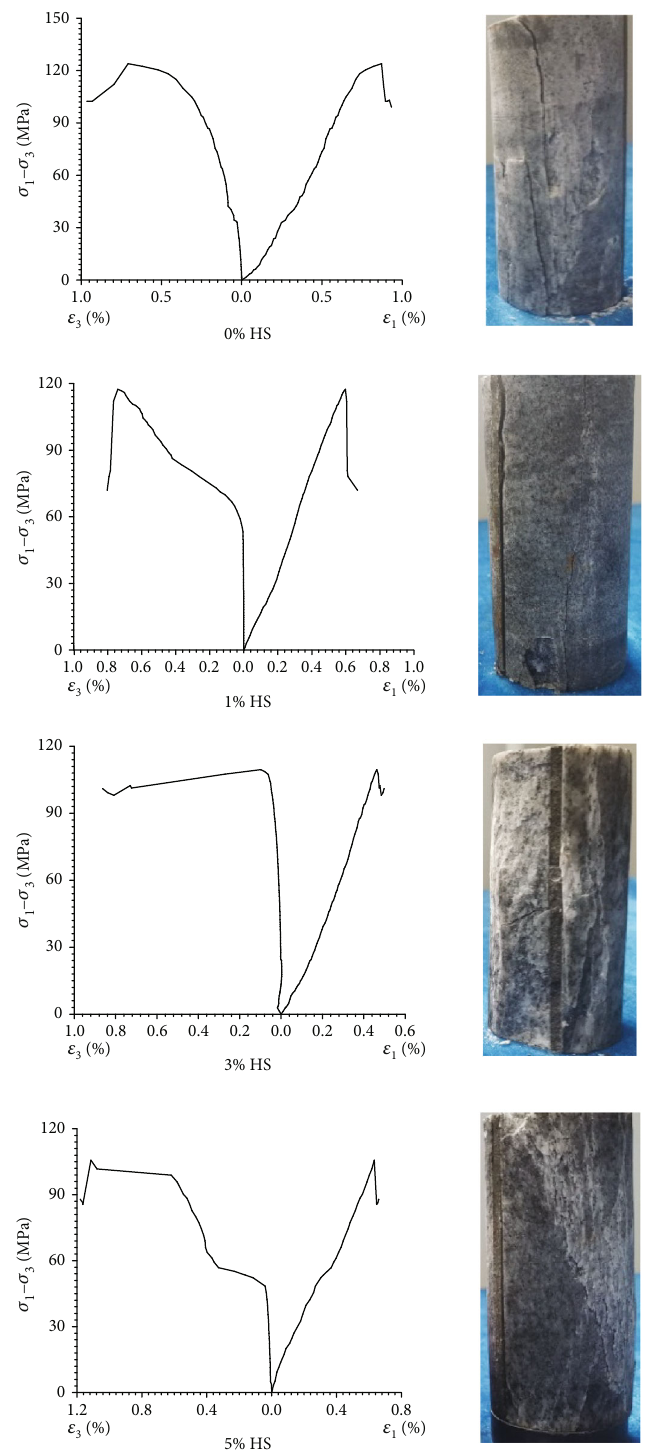
Figure 7: Stress-strain curve and typical failure mode of specimens with di ff erent HS admixture